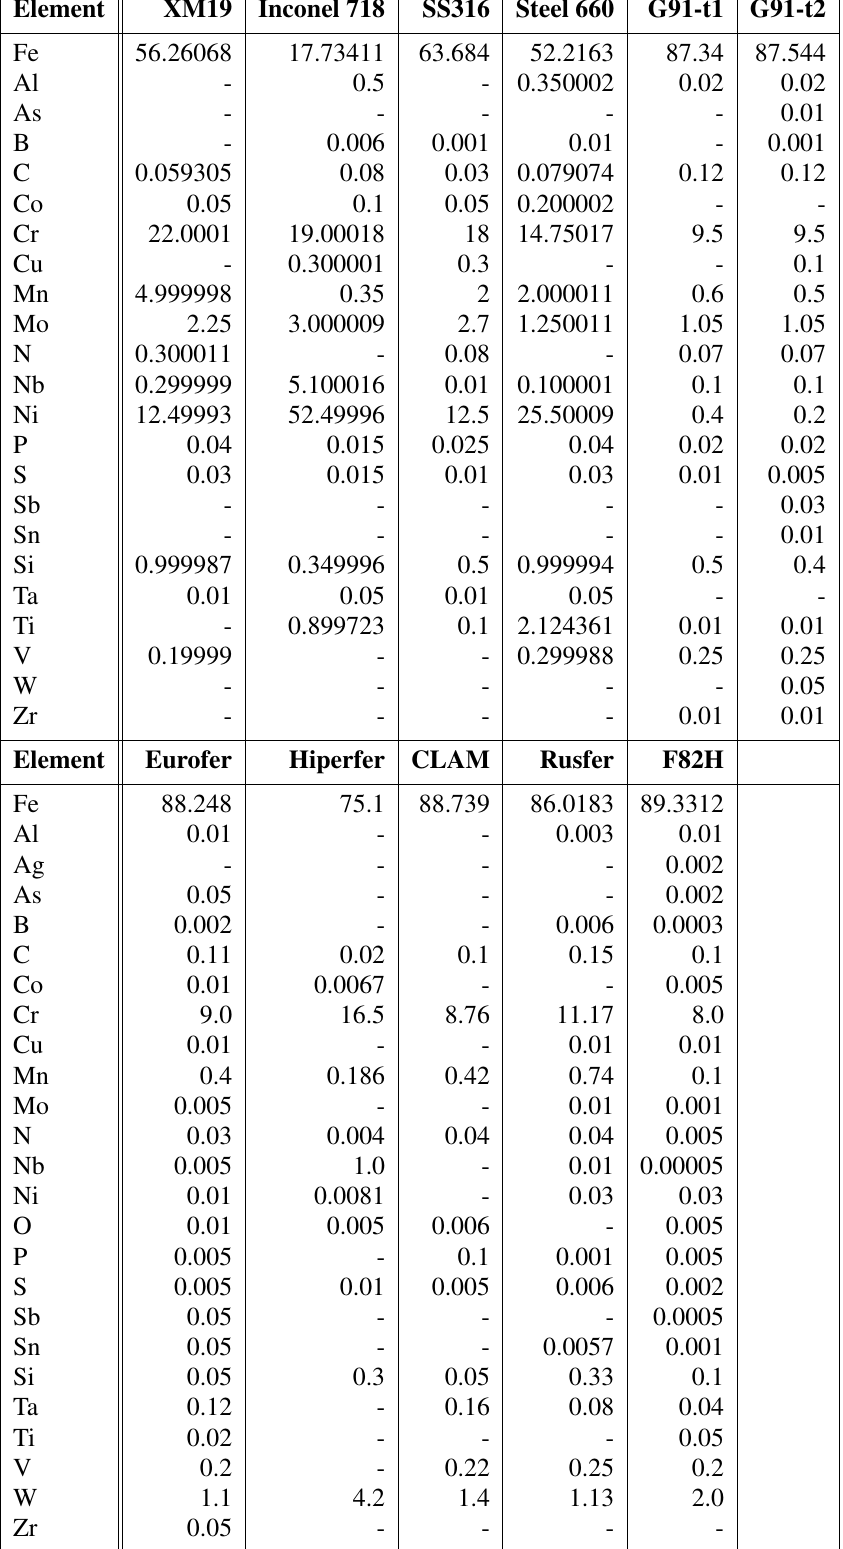
Table 4: The elemental composition, by percentage weight, of the steels studied